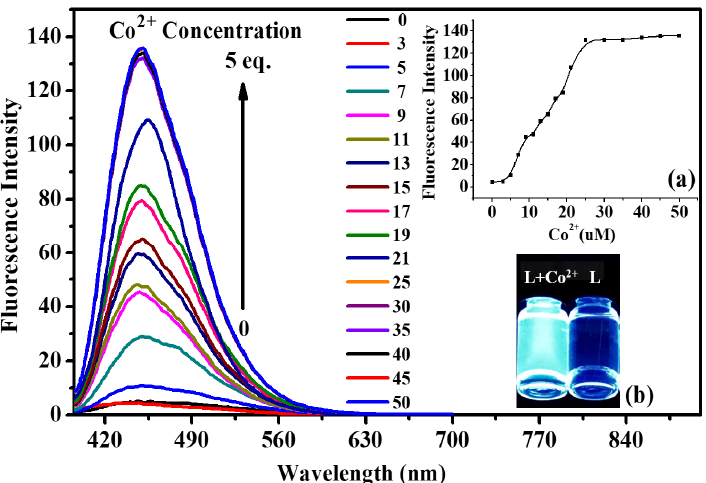
Figure 3. Changes in the fluorescence spectra of L (1 × 10 − 5 mol L − 1 , λ ex = 380 nm) after the addition of increasing amounts of Co 2+ (zero-to-five equivalents) in CH 3 CN/HEPES (4/1, v / v , pH = 7.4) at room temperature. Inset: ( a ) The curve fitting of the fluorescence titration; ( b ) the color changes observed by UV light of L (1 × 10 -5 mol L -1 ) and upon addition of five equivalents of Co 2+ in CH 3 CN/HEPES (4/1, v / v , pH = 7.4).